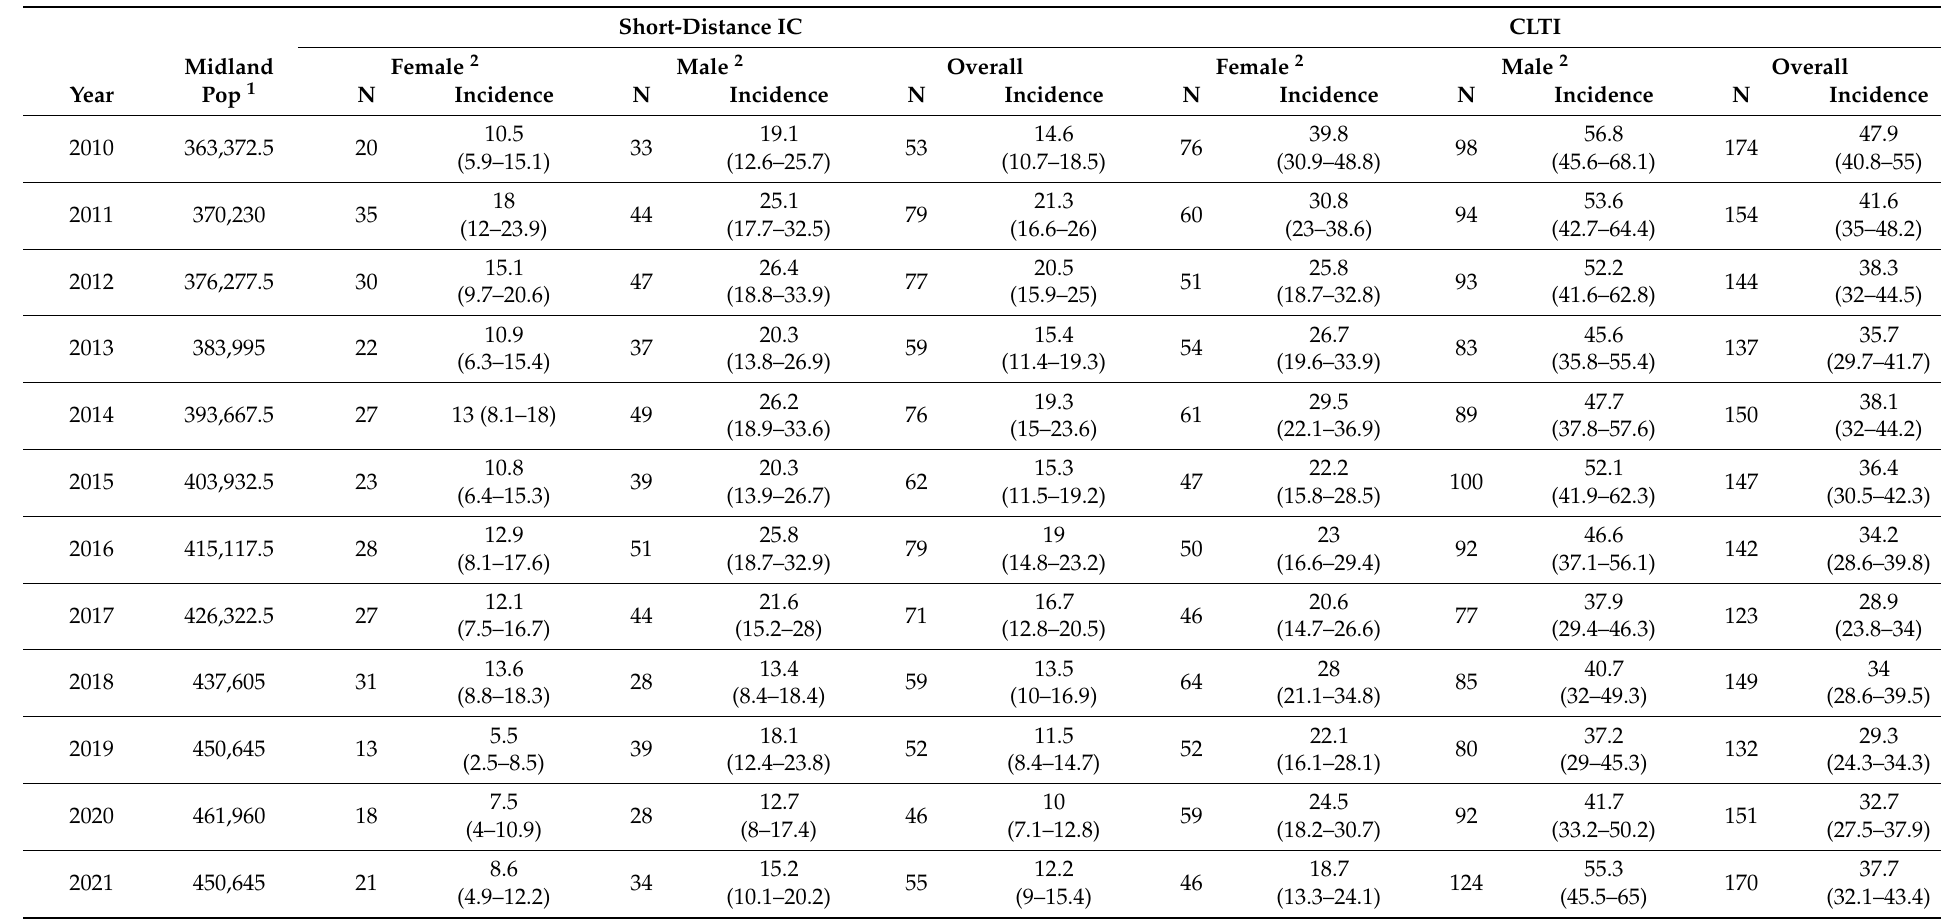
Table 2. The incidence of short-distance IC and CLTI in Midland region as separated by sex. Shown are 95% confidence intervals. Short-Distance IC